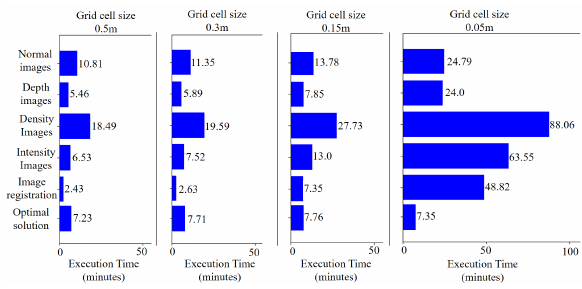
Figure 15. Execution time of algorithm’s main steps when